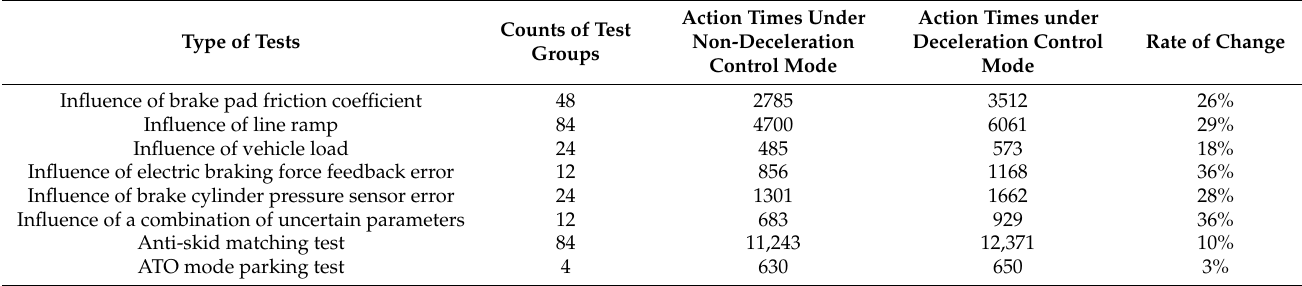
Table 4. Action times of the electro-pneumatic